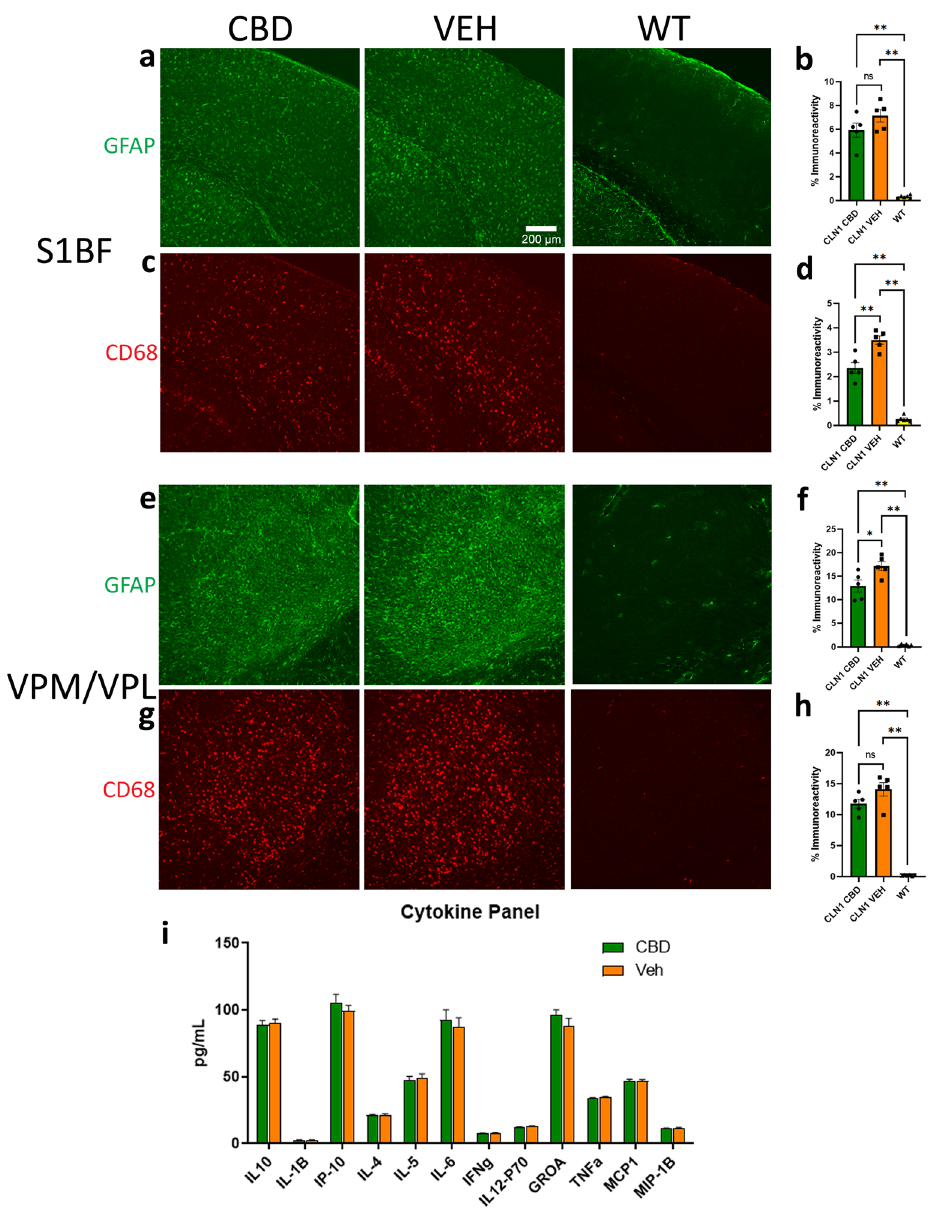
Figure 1. Treatment with CBD reduces some disease-related pathology. In S1BF, chronic CBD did not affect GFAP immunoreactivity ( a , b ) but did significantly reduce CD68 expression ( c , d ) in Cln1 −/− mice. Conversely, GFAP expression was reduced following CBD treatment ( e , f ) while CD68 immunoreactivity was unchanged ( g , h ) in Cln1 −/− VPM/VPL. Chronic CBD did not significantly affect any of the cytokines analyzed ( i ). Data shown are means ± SEM. *Indicates p < 0.05; **indicates p < 0.01. Scale bar is 200